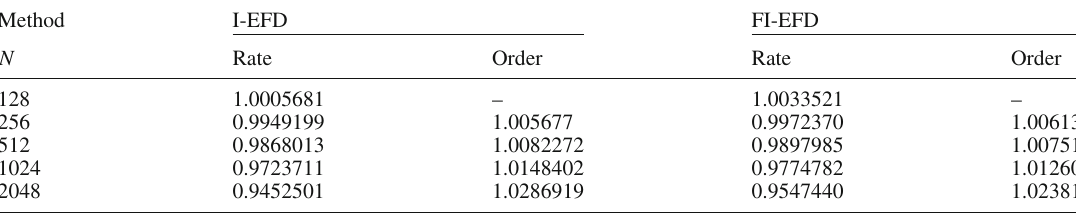
Table 11 Rate and order of convergence for T = 2 ,(cid:2) x = 0 . 1, and (cid:2) t changes, Example